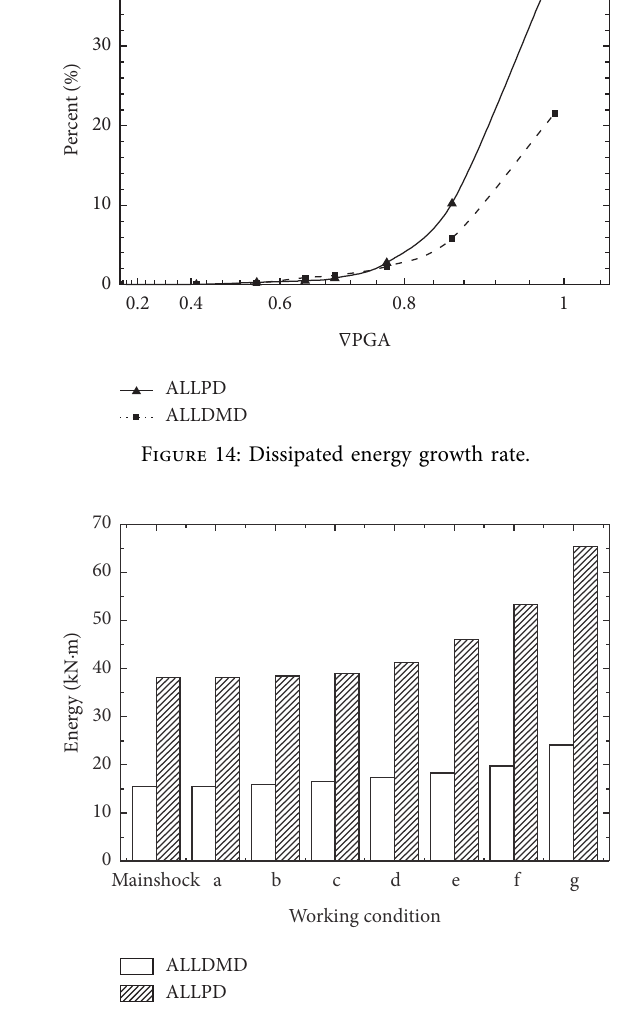
Figure 15: Dam foundation dissipated